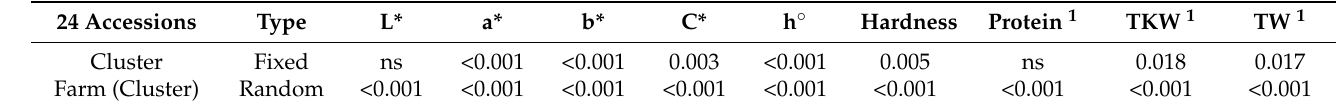
Table 4. Results of the ANOVA performed on commercial quality data in the 24 Solina